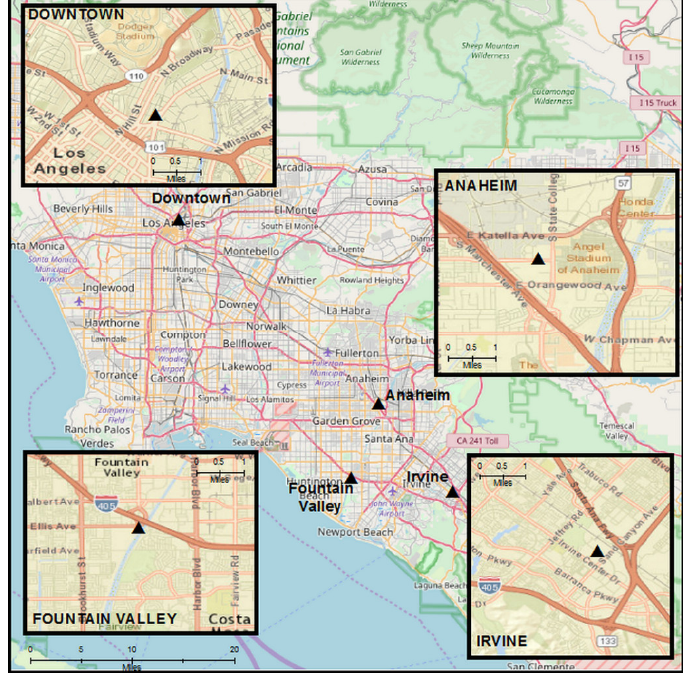
Figure 1. Survey sites and regional map, with insets of detailed street networks near the compressed natural gas (CNG) refueling stations.